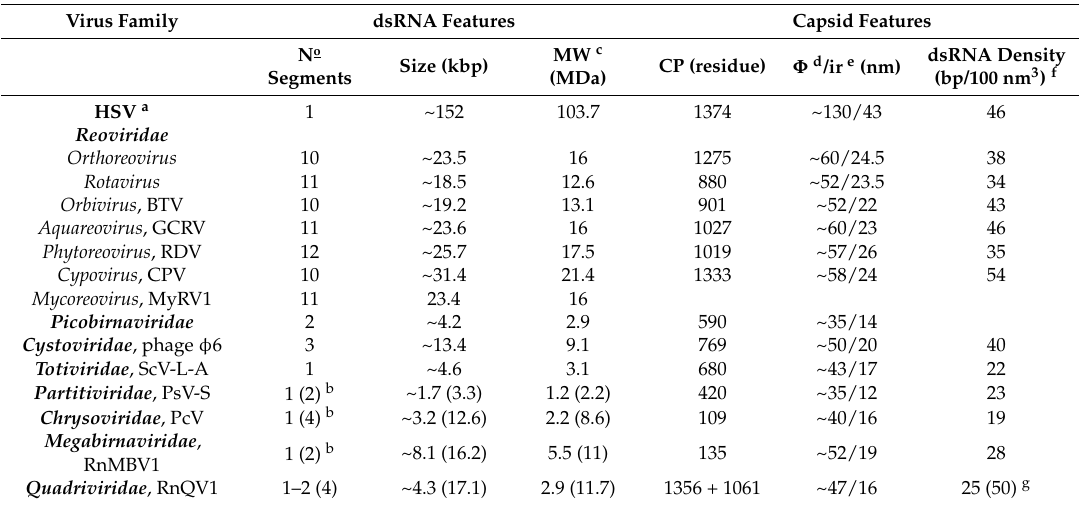
Table 1. Genome packaging densities in double-stranded ribonucleic acid (dsRNA) viruses. Virus Family dsRNA Features Capsid Features N o